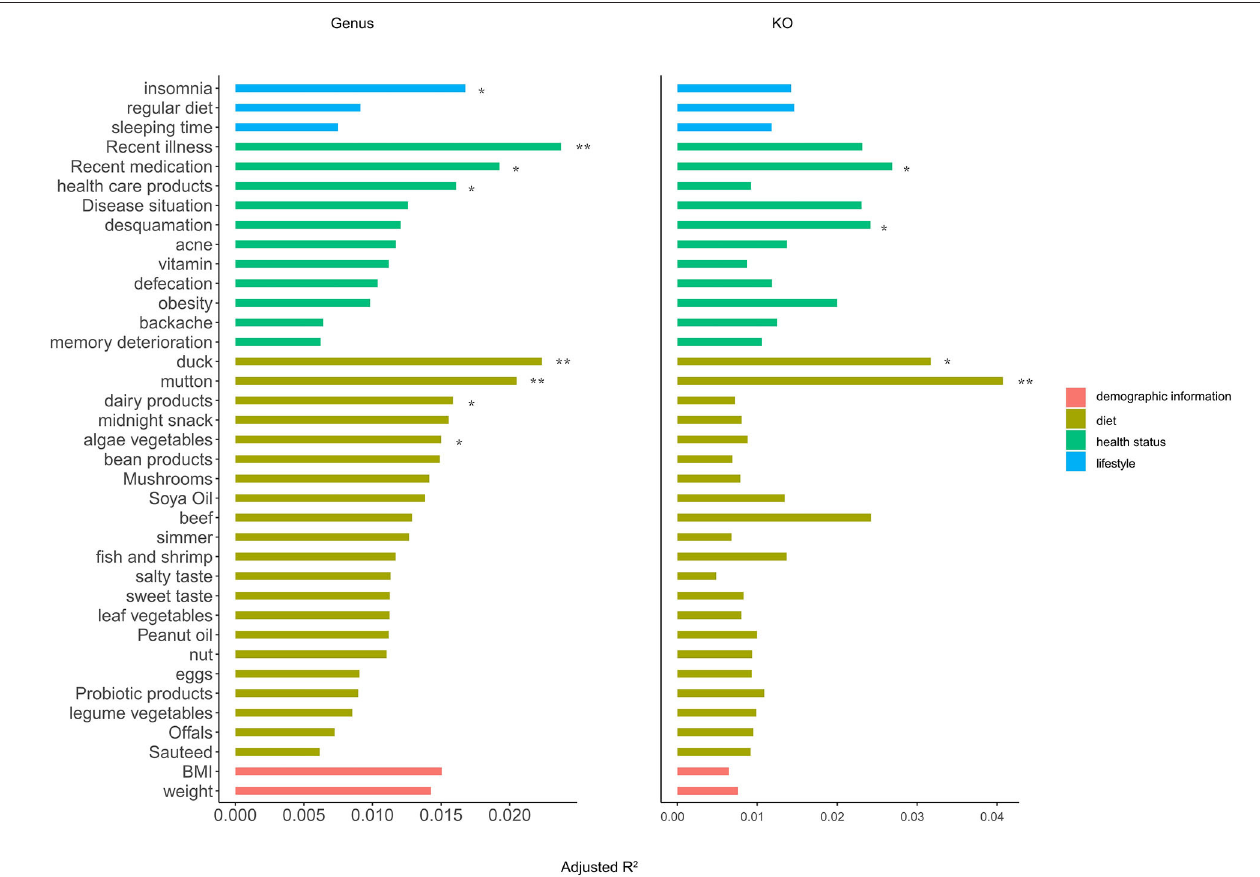
FIGURE 4 | Identification of the gut microbial covariates in the OFWs cohort. Horizontal bars showing the amount of inferred variance (adjusted R 2 ) explained by each identified covariate as determined by PERMANOVA with Bray–Curtis dissimilarities at the genus (left) and KO (right) levels. The categories are color-coded and ranked by the highest explained variation in the respective category. Only statistically significant covariates with an adjusted p < 0.05 using the Benjamini–Hochberg (BH) method are shown. **BH-adjusted p < 0.01 ; *BH-adjusted p < 0.05